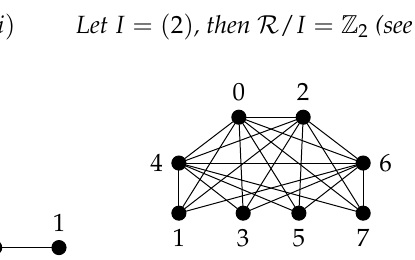
Figure 1. ( left ) T Z ( R / I ) ( Γ ( R / I )) and ( right ) T I ( Γ ( R )) , when R = Z 8 and I = ( 0 ) .